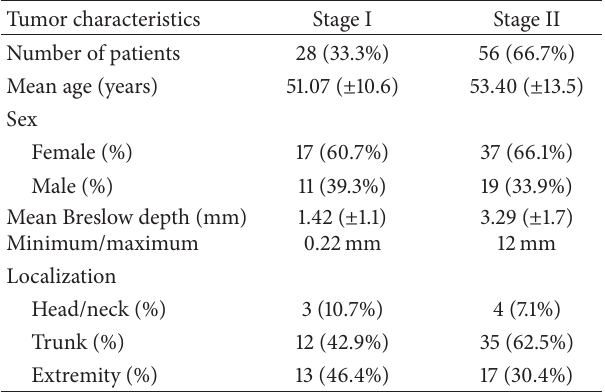
Table 1: Patient demographics ( 𝑁 = 84